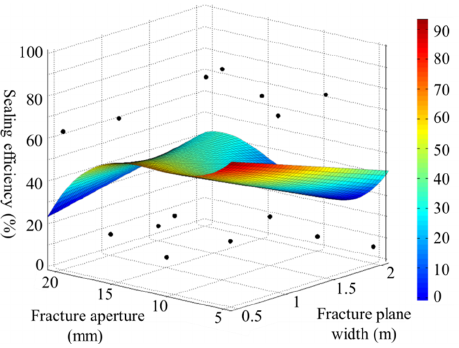
Figure 16. Influence of fracture plane width and fracture aperture on sealing efficiency.